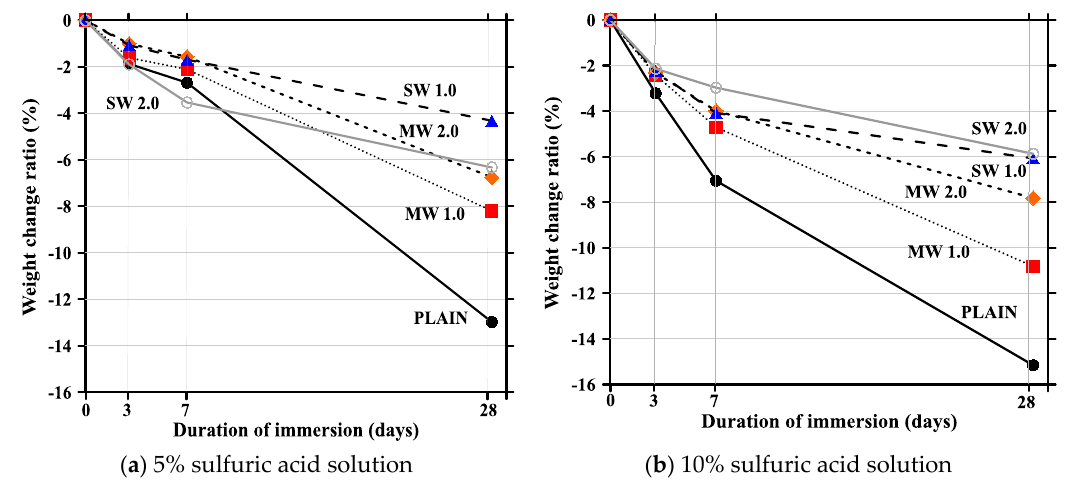
Figure 7. Weight change ratio of cementitious composites immersed in sulfuric acid solution: ( a ) 5% and ( b ) 10%.